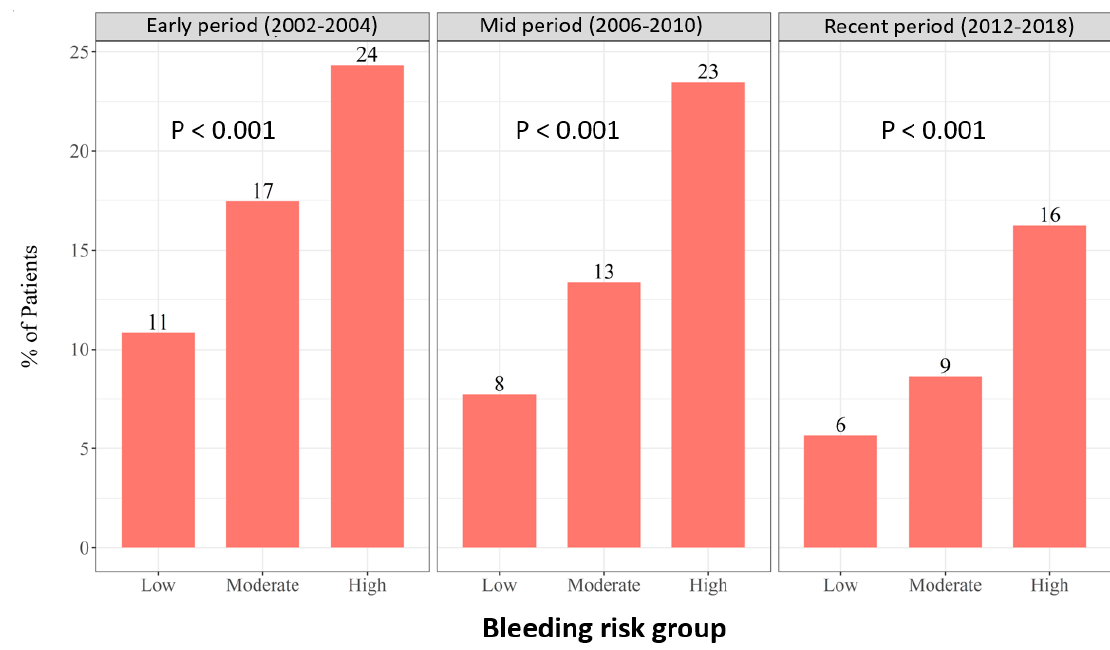
Figure 2. The 30-day MACE according to bleeding risk and enrolment